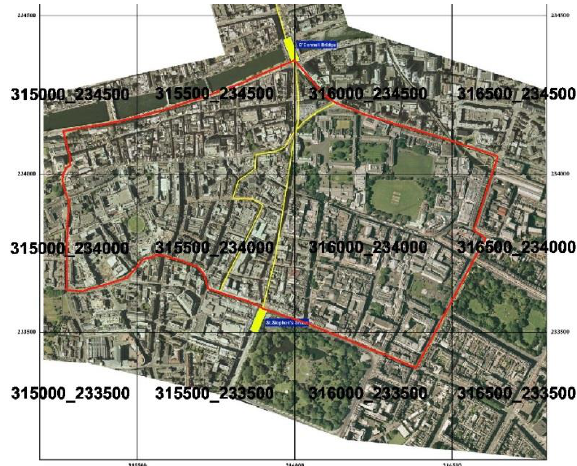
Figure 1. Acquired ALS area in Dublin central and ALS tiles (contest area outlined in red)